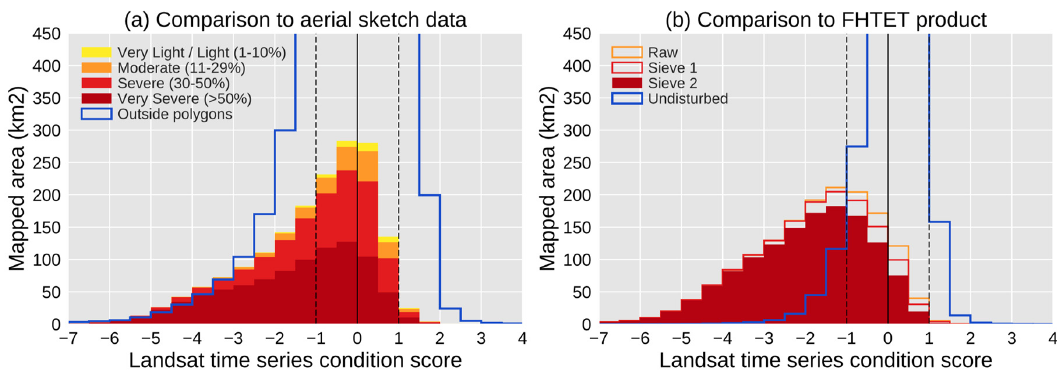
Figure 5. Histograms showing distribution of Landsat Time Series (LTS) condition scores relative to two other defoliation assessments of forested areas in Southern New England in 2016: ( a ) aerial sketch maps (provided by USFS regional office), and ( b ) a remote sensing-based Forest Health Technology Enterprise (FHTET) assessment. Histograms in red tones indicate distributions for areas assessed as defoliated during the 2016 gypsy moth outbreak, while the blue line shows the distribution of scores outside of defoliated areas. The aerial sketch histogram includes four levels of defoliation, while the FHTET histogram shows distributions for three different products: raw results and two post-processed maps where sieving was used to remove isolated pixels. Dotted lines indicate the range between − 1.0 and 1.0, assumed to represent little to no damage.